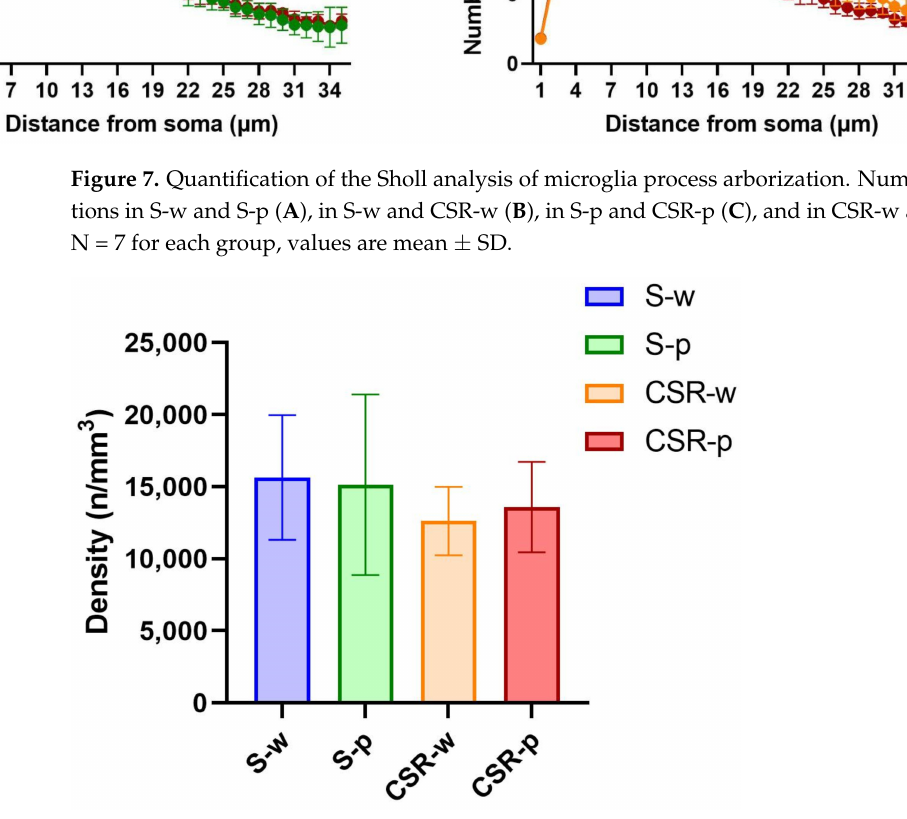
Figure 8. Density of microglia. Quantification of the density of microglial cells in all groups. Values are mean ±